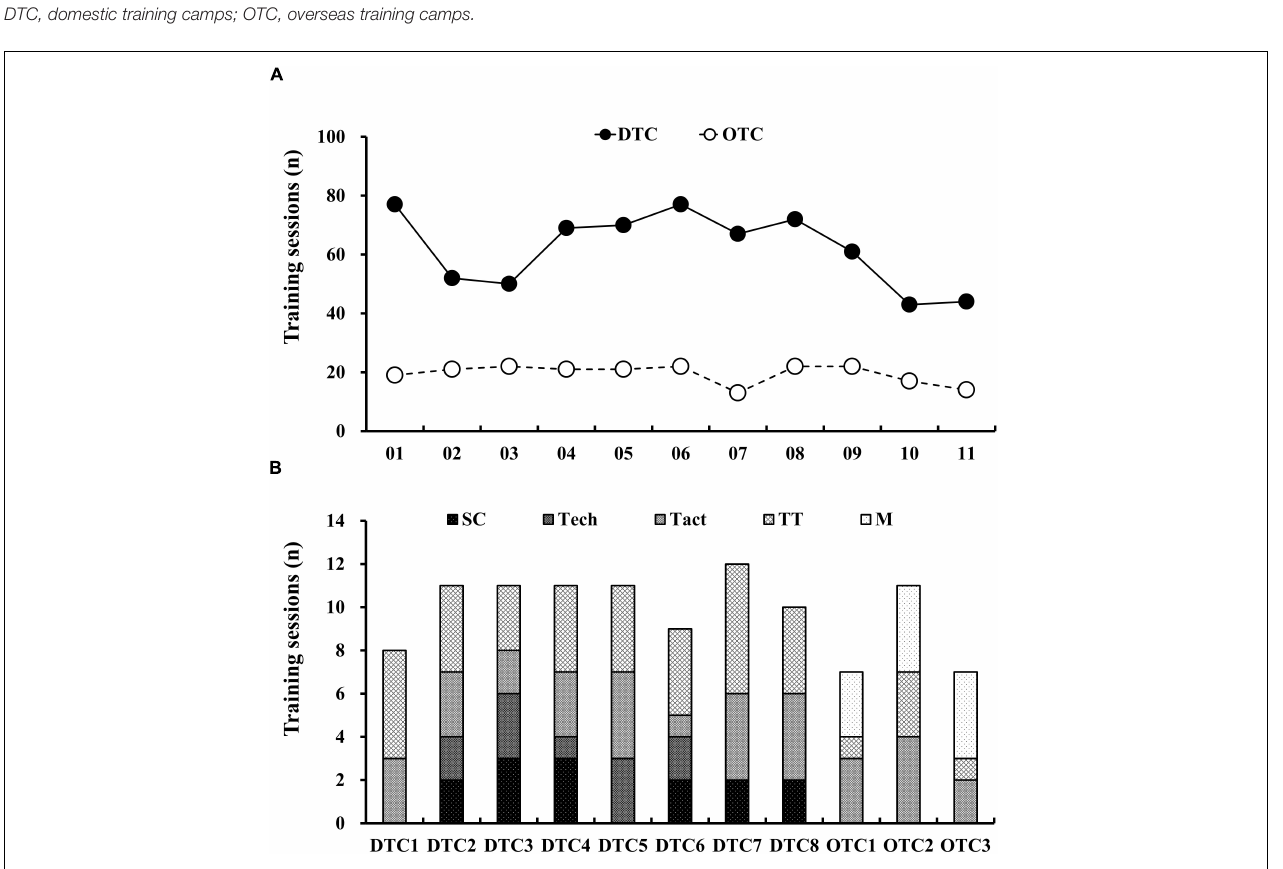
FIGURE 1 | The total number of training sessions during domestic and overseas training camps. (A) The total number of training sessions for each individual player. (B) The total number of training sessions for the group. DTC, domestic training camps; OTC, overseas training camps; S&C, strength and conditioning sessions; Tech, technical training sessions; Tact, tactical training sessions; TT, technical and tactical training sessions; M, friendly